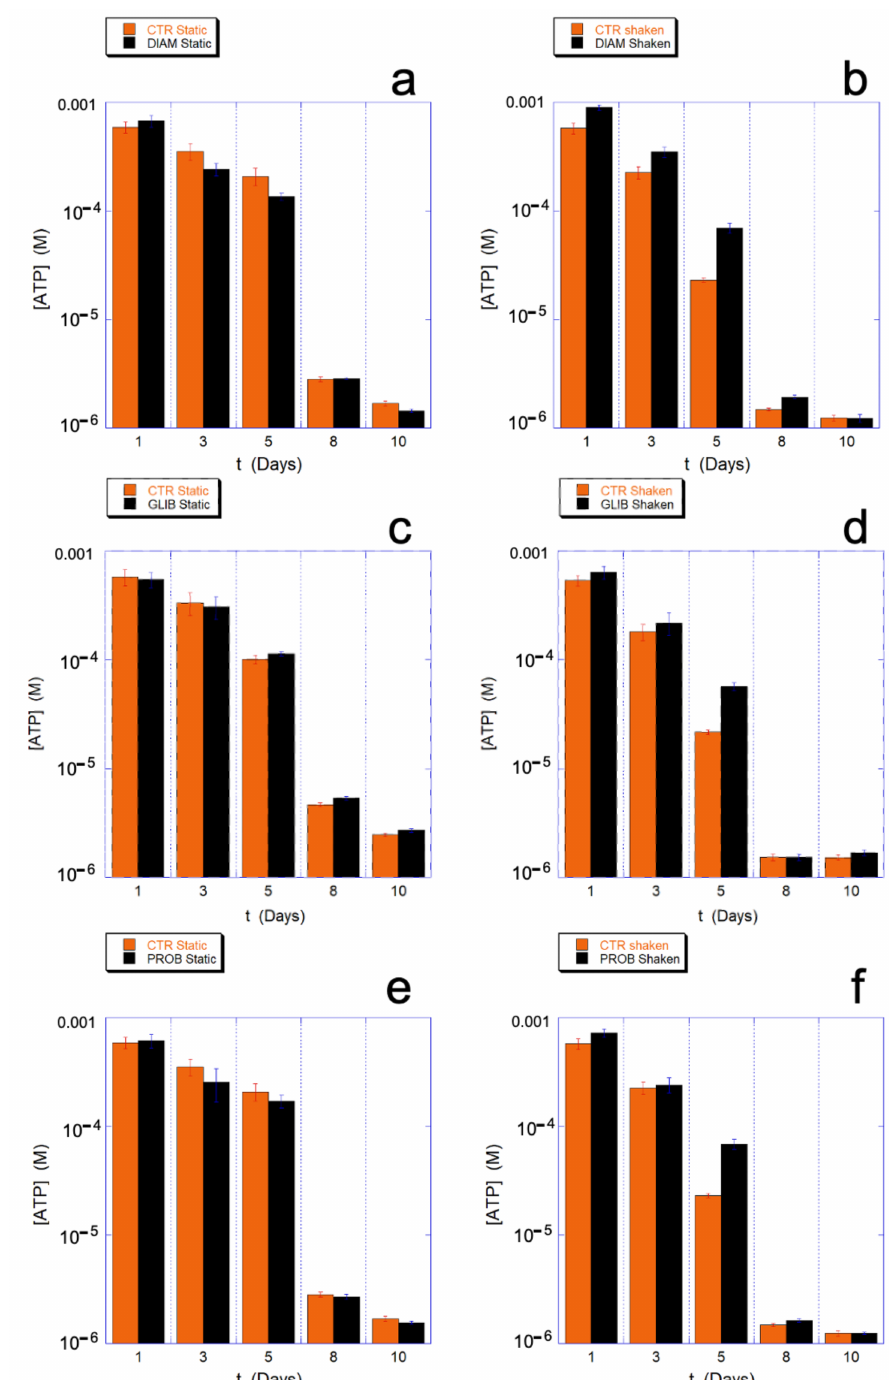
Figure 10. Intracellular ATP measured at various aging times in static ( a , c , e ) and mechanically stimulated ( b , d , f ) samples in the presence and absence of drugs that interfere with the mechano- transduction. Respectively, DIAM ( a , b ); GLIB ( c , d ), and PROB ( e , f ) and their specific controls are shown. The data evidence that the drugs have no significant effect in static conditions, while, in the presence of mechanical stimulation, n higher amount of ATP can be measured, at least during the critical aging phase when higher consumption of resource is required (i.e., the fifth day). Data analogous to PROB were measured for CARB. The ATP concentrations are shown in log